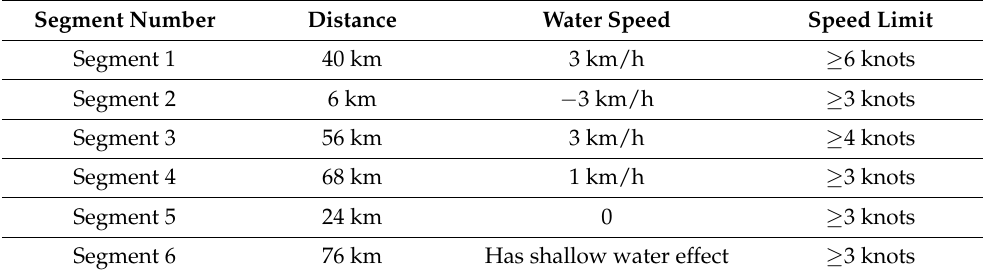
Table 3. The voyage information of case